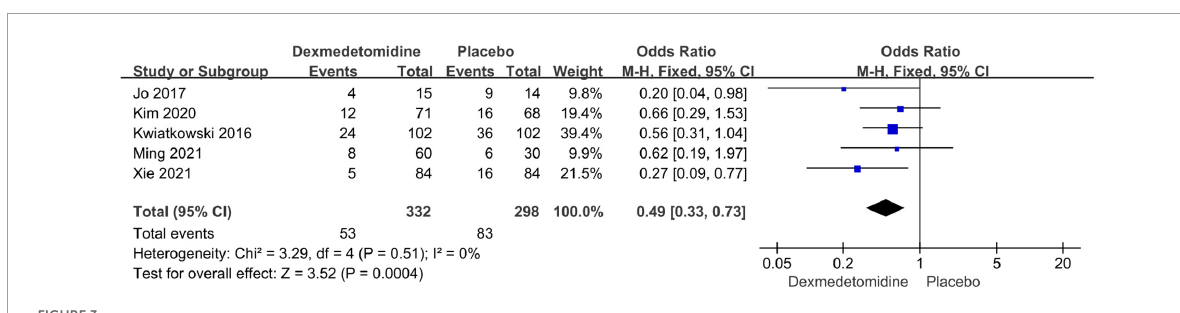
Subgroup analyses were performed according to the types of CHD and dexmedetomidine intervention